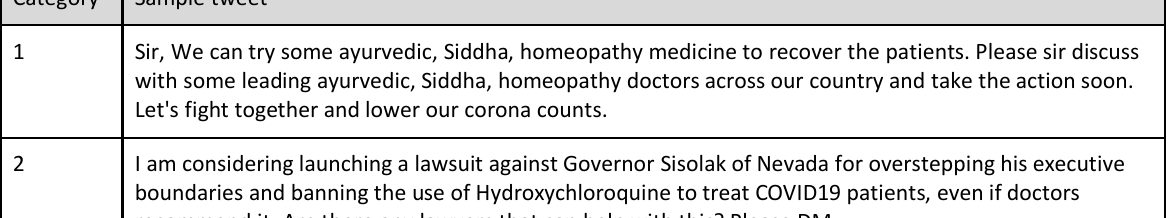
Table 2. A list of identified tweets that contain misinformation about COVID-19 and a cure.